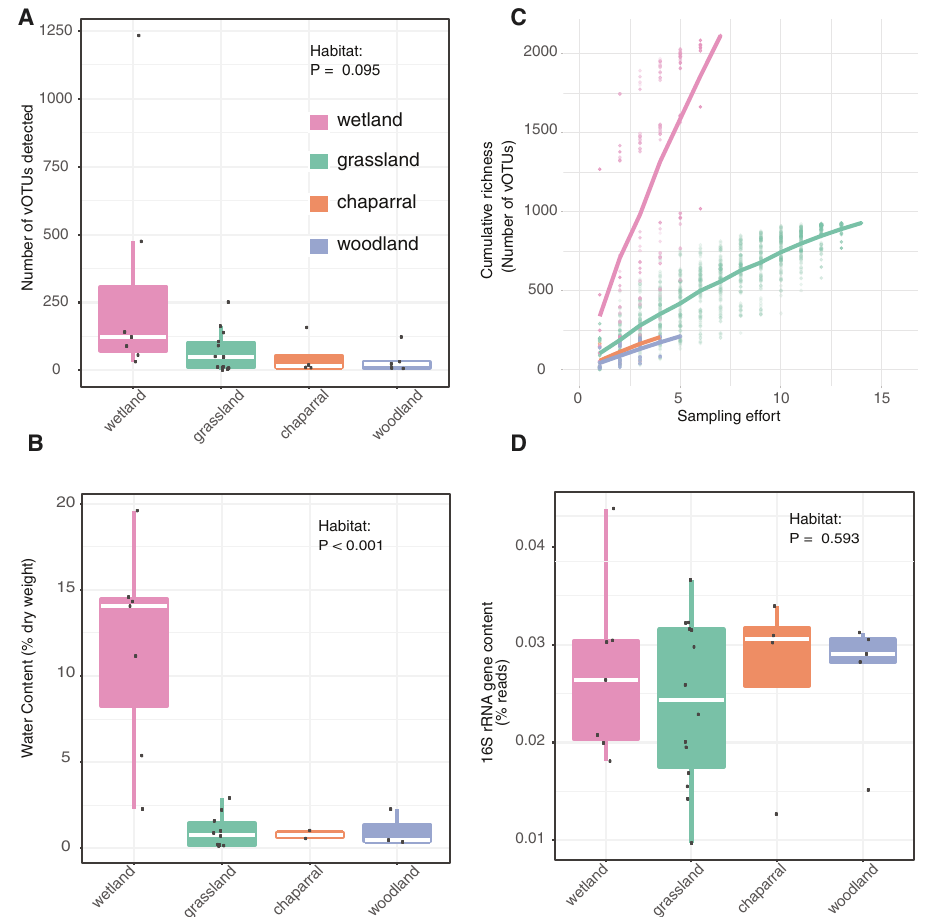
Fig. 1 Evidence for higher viral richness in wetter soils. Comparisons between habitats of ( A ) viral richness (number of identi fi ed vOTUs with coverage along at least 75% of the contig in a given virome), dots represent richness in individual viromes, ( B ) accumulation curves of cumulative vOTU richness as sampling effort increased, dots represent cumulative richness at each sampling effort across 100 permutations of virome order; the overlaid lines display the mean cumulative richness per habitat, ( C ) water content, calculated as (wet weight — dry weight) divided by dry weight, and ( D ) bacterial 16S rRNA gene content in the viromes, based on percent of viromic reads mapping to 16S rRNA reference genes. VIBRANT [21] was used to identify 3,490 viral contigs in our assemblies, and these viral contigs were clustered at 95% average nucleotide identity (ANI) into 3432 viral operational taxonomic units (vOTUs). For ( A ), ( B ), ( D ), raw data are plotted on top of the box plots, with white lines showing the median, boxes indicating 75% of the data, whiskers extending to 90%, and points beyond the whiskers indicating Multiple lines of evidence suggest that wetter soils harbored greater viral diversity than drier soils. We recovered the most vOTUs from wetlands, both in total (56% of all vOTUs were from wetlands) and per virome (on average, 307 vOTUs were recovered per wetland virome, compared to 116 from all habitats) (Fig. 1A). Unsurprisingly, wetlands had signi fi cantly greater moisture content than other habitats (Fig. 1B; ANOVA followed by Tukey multiple comparisons of means, p < 0.001), especially considering that soil samples were collected towards the end of the Mediterranean climate dry season, meaning that most habitats had not received precipitation for the preceding ~6 months. Although viral richness was highest in wetlands, this was not statistically signi fi cant (ANOVA model richness ~ habitat, p = 0.095). Still, nonparametric tests, which account for nonlinear correlations, revealed a signi fi cantly positive correlation between viral richness and soil moisture content (Spearman rho = 0.33, p = 0.036; Kendall tau = 0.22, p = 0.045). Viral community beta-diversity was also related to soil chemical properties overall (Mantel test, R 2 = 0.43, p = 0.009; Table S1), while distance between sites only accounted for 5% of the variation (Partial Mantel test, R 2 = 0.38, p = 0.009). Taken together, viral diversity was generally highest in wet soils.